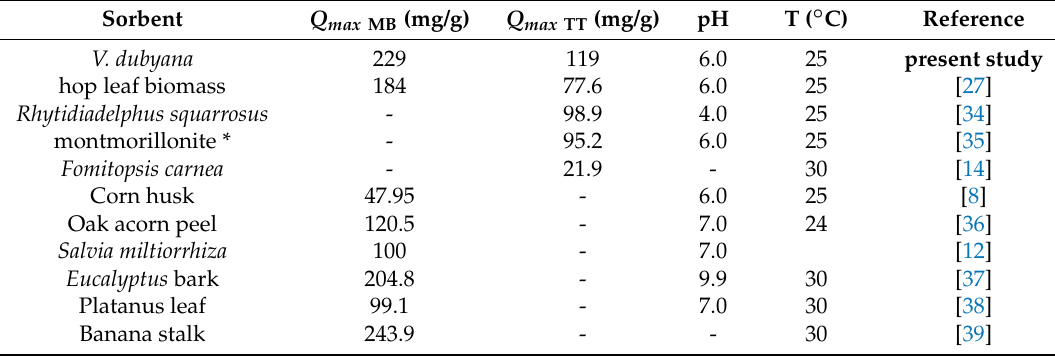
Table 3. Comparison of Q max values of different sorbents determined from Langmuir isotherm for TT and